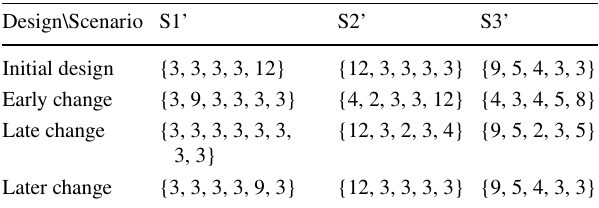
Fig. 10 Updated starting oil flow rates (tn/day) of every well of a 24-well pad for three scenarios S1 ′ , S2 ′ and S3 ′ (numbers 1–24 enu- merate wells, with flow rates being measured along the radial direc- tion)